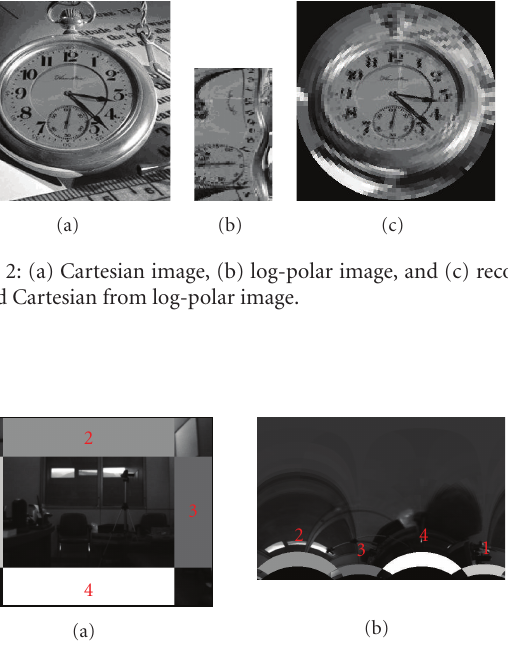
Figure 3: The selected subimages for motion estimation, in the Cartesian and log-polar plane,